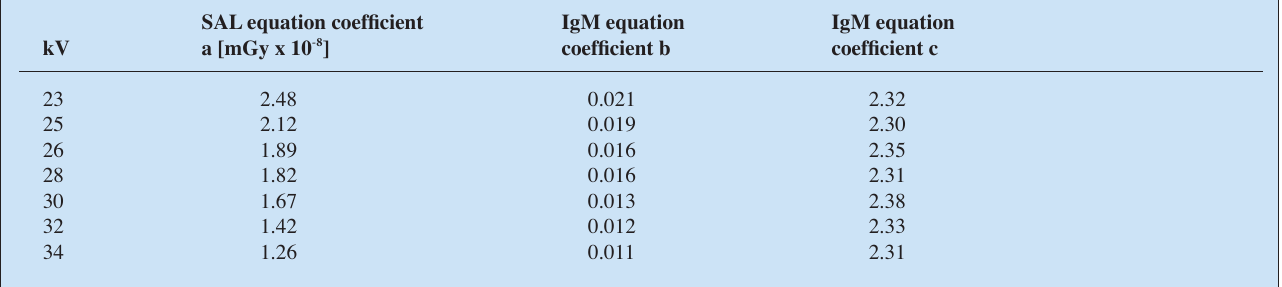
Table II. Summary of equation coefficients from the regression equations obtained from regression fits shown in Figs 1 and 2